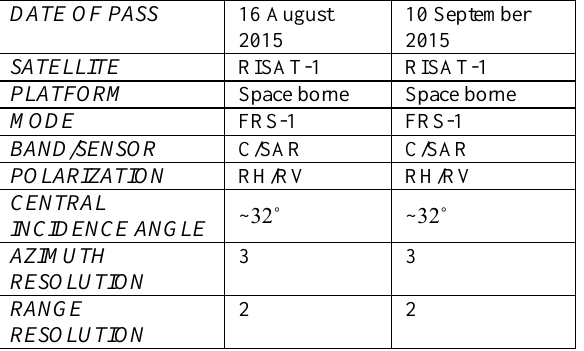
Table 1. Specifications of SAR data and sensor parameters used in this